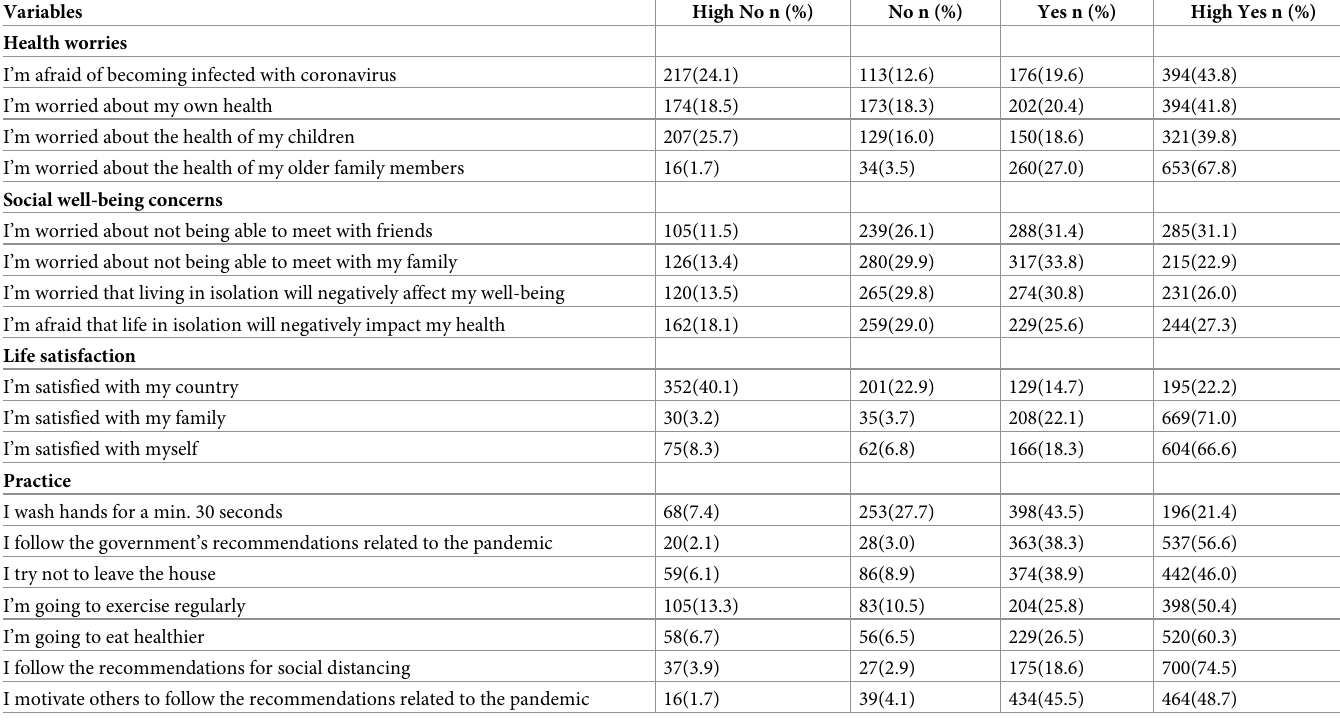
Table 2. Mental well-being outcomes and COVID-19 practices among